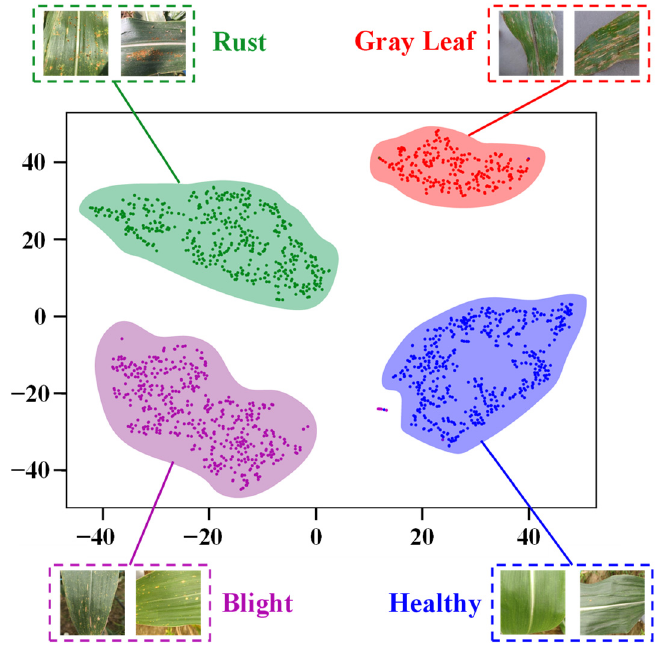
Figure 6. t-SNE visualization of the feature representations of the validation set.